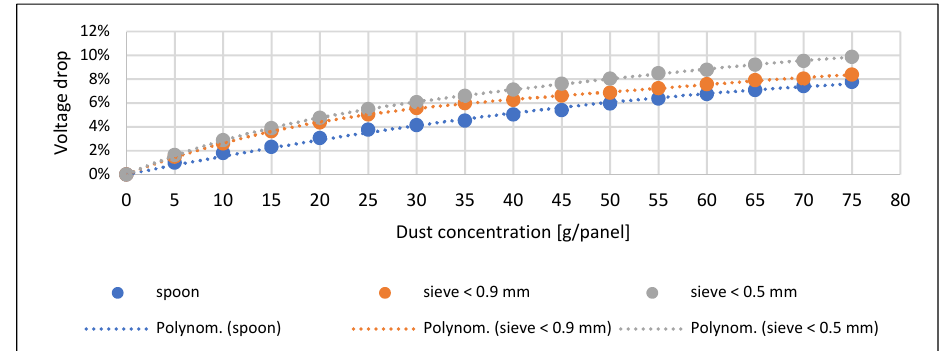
Figure 4. The open ‐ circuit voltage values as a function of the soil concentration. Figure 4. The open-circuit voltage values as a function of the soil